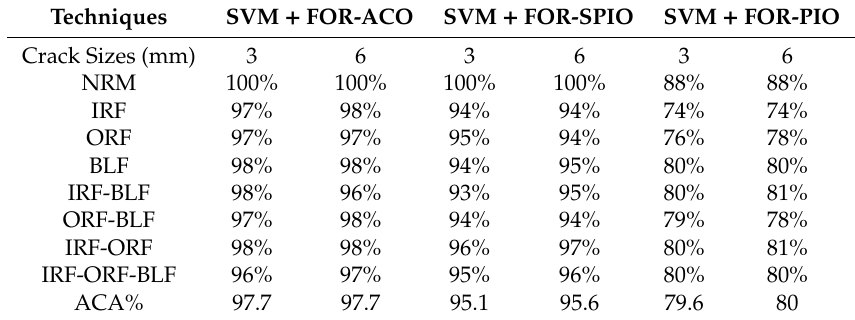
Table 12. The Accuracy of Multi-Type Fault Identification When the Torque Speed is 450-RPM.